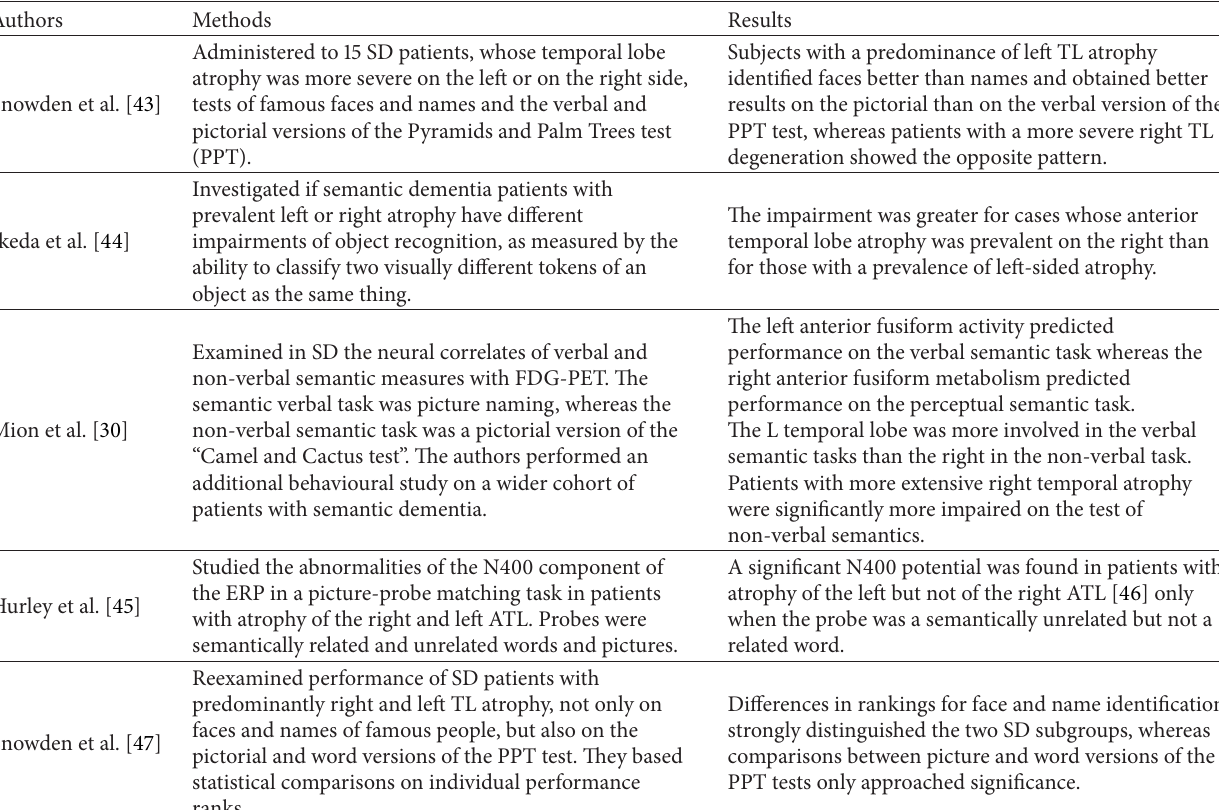
Table 2: Data obtained in investigations which contrasted performances obtained on verbal and non-verbal semantic tasks by patients with semantic dementia (SD) with prevalent right or left anterior temporal lobe (ATL)